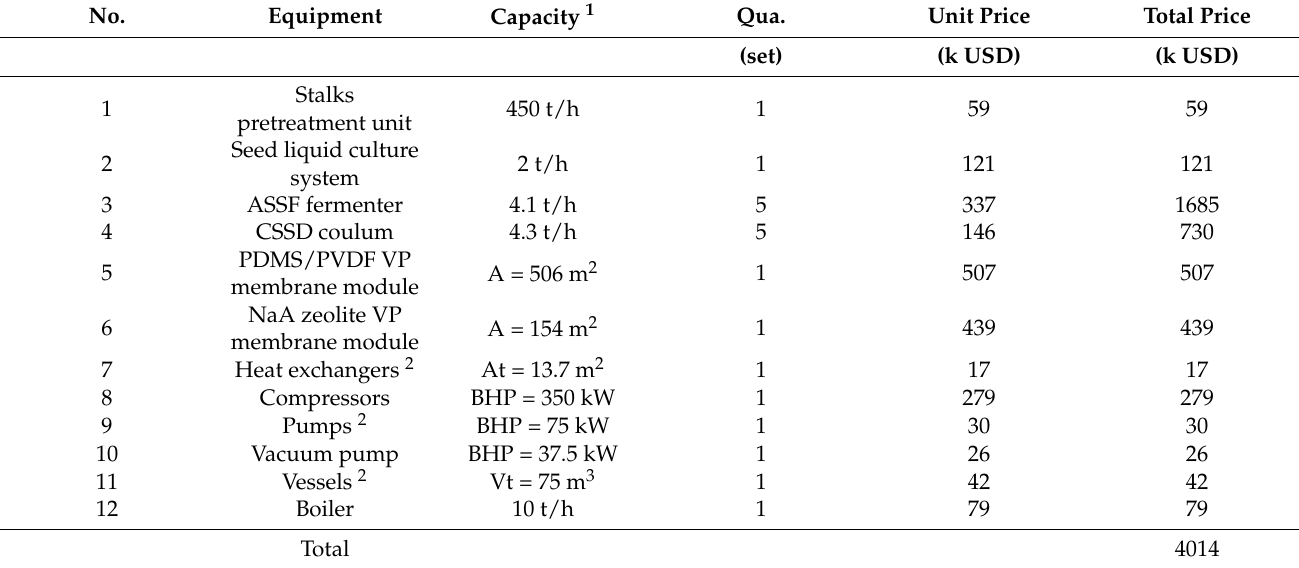
Table 4. Purchased Equipment costs for OPTS bioethanol